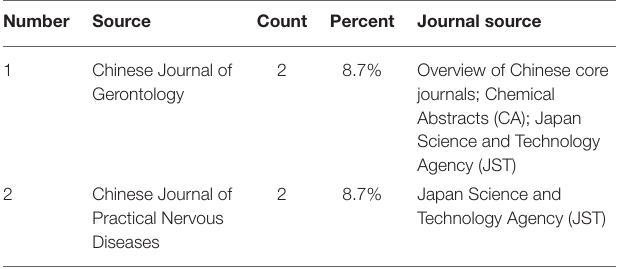
TABLE 1 | Top 2 source of journals published in Chinese language. TABLE 2 | Top 5 source of journals published in English